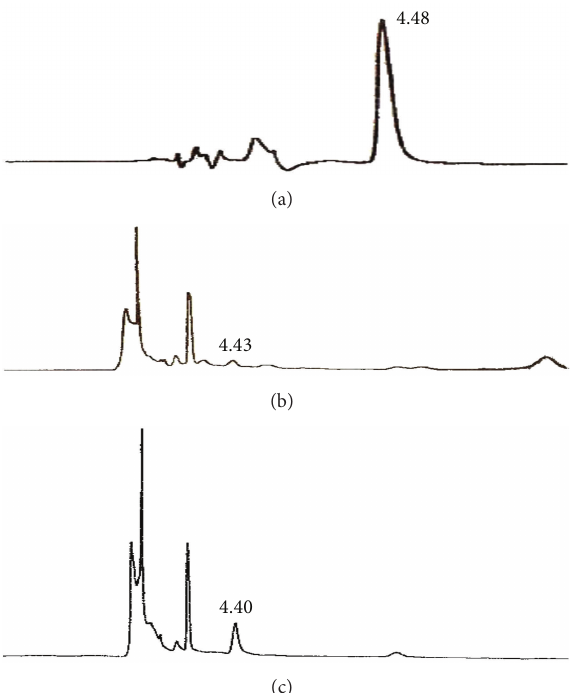
Figure 1: Chromatograms from the analysis of lycorine in H. littoralis . (a) Standard lycorine 6.25 𝜇 g/mL. (b) Anther extract at 400 𝜇 g/mL. (c) Extract of callus culture obtained with 4.5 𝜇 M 2,4-D and 0 𝜇 M BAP at 1000 𝜇 g/mL. Column: Eclipse Plus reversed-phase C-18 (250 mm × 4.6 mm i.d., 5 𝜇 m); mobile phase: acetonitrile-1% aqueous ammonium acetate buffer (15:85 v/v); flow rate: 1.0mL/min; wavelength: 325 nm.